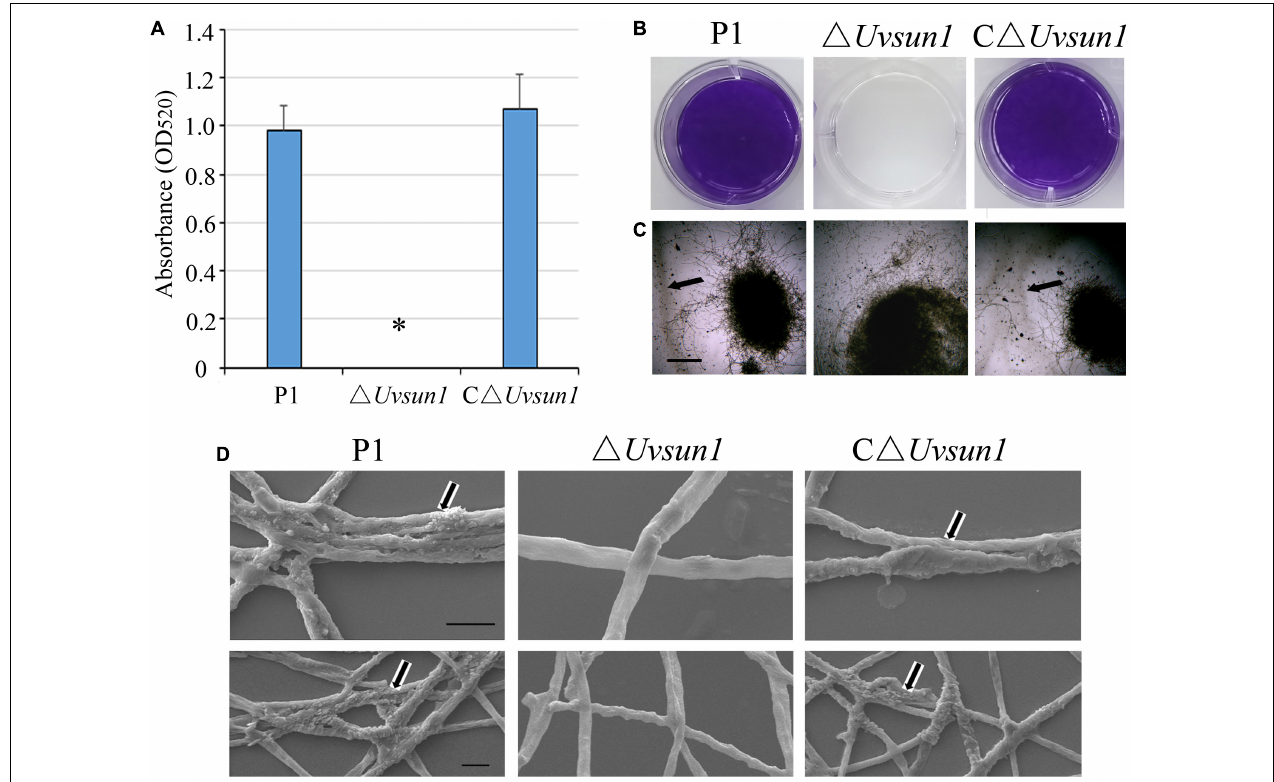
FIGURE 4 | Lack of Uvsun1 induces cell surface alterations. (A) The density of films was estimated by the absorbance measurements of the destaining crystal violet solution at 520 nm. (B) Formation of films by hyphae of the indicated strains after 24 h growth on polystyrene plates. After washing, hyphae were stained with crystal violet for visualization. (C) ECM displayed by the (cid:49) Uvsun1 mutant, as compared with the wild type P1 and complemented strain C (cid:77) Uvsun1 , detected by India ink staining of conidia germinated in YT medium for 7 days (Scale bars, 200 µ m). (D) Scanning electron micrographs of hyphae of the indicated strains for 7 days. Magnification was 20,000 × (up, Scale bars, 2 µ m) and 10,000 × (down, Scale bars, 10 µ m). All assays were performed on at least three independent occasions.